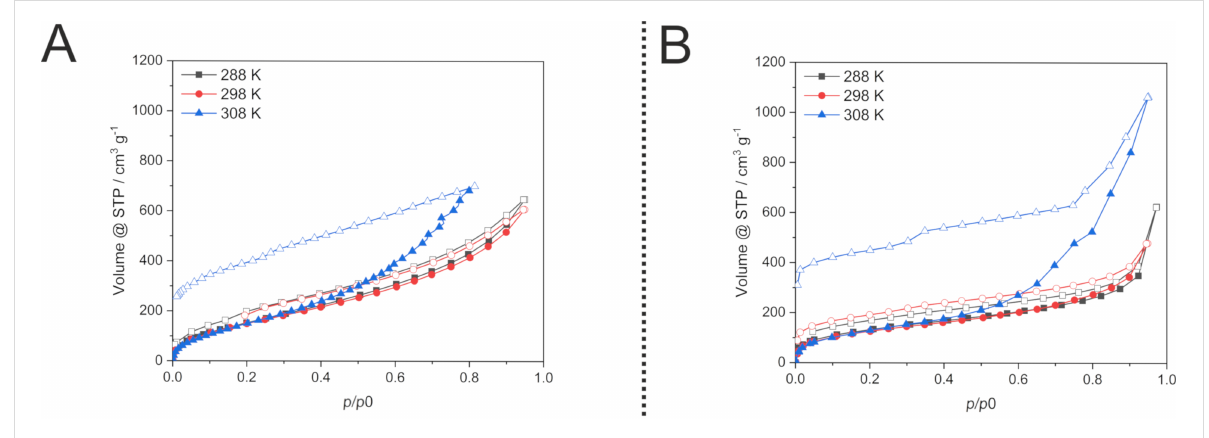
Figure 5: Physisorption isotherms of benzene vapour at different temperatures on HCP synthesised classically from solution (left, A) and mechanochemically (right, B). Filled symbols denote adsorption and open symbols desorption, respectively.